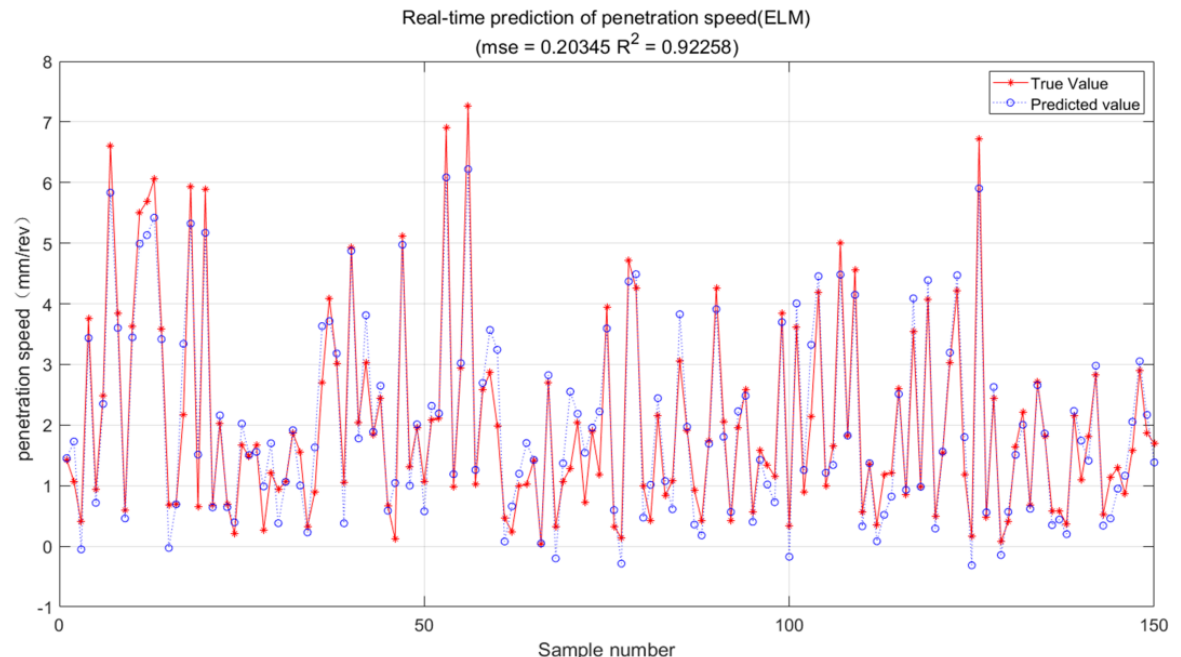
Figure 6. Real-time prediction of the penetration speed.